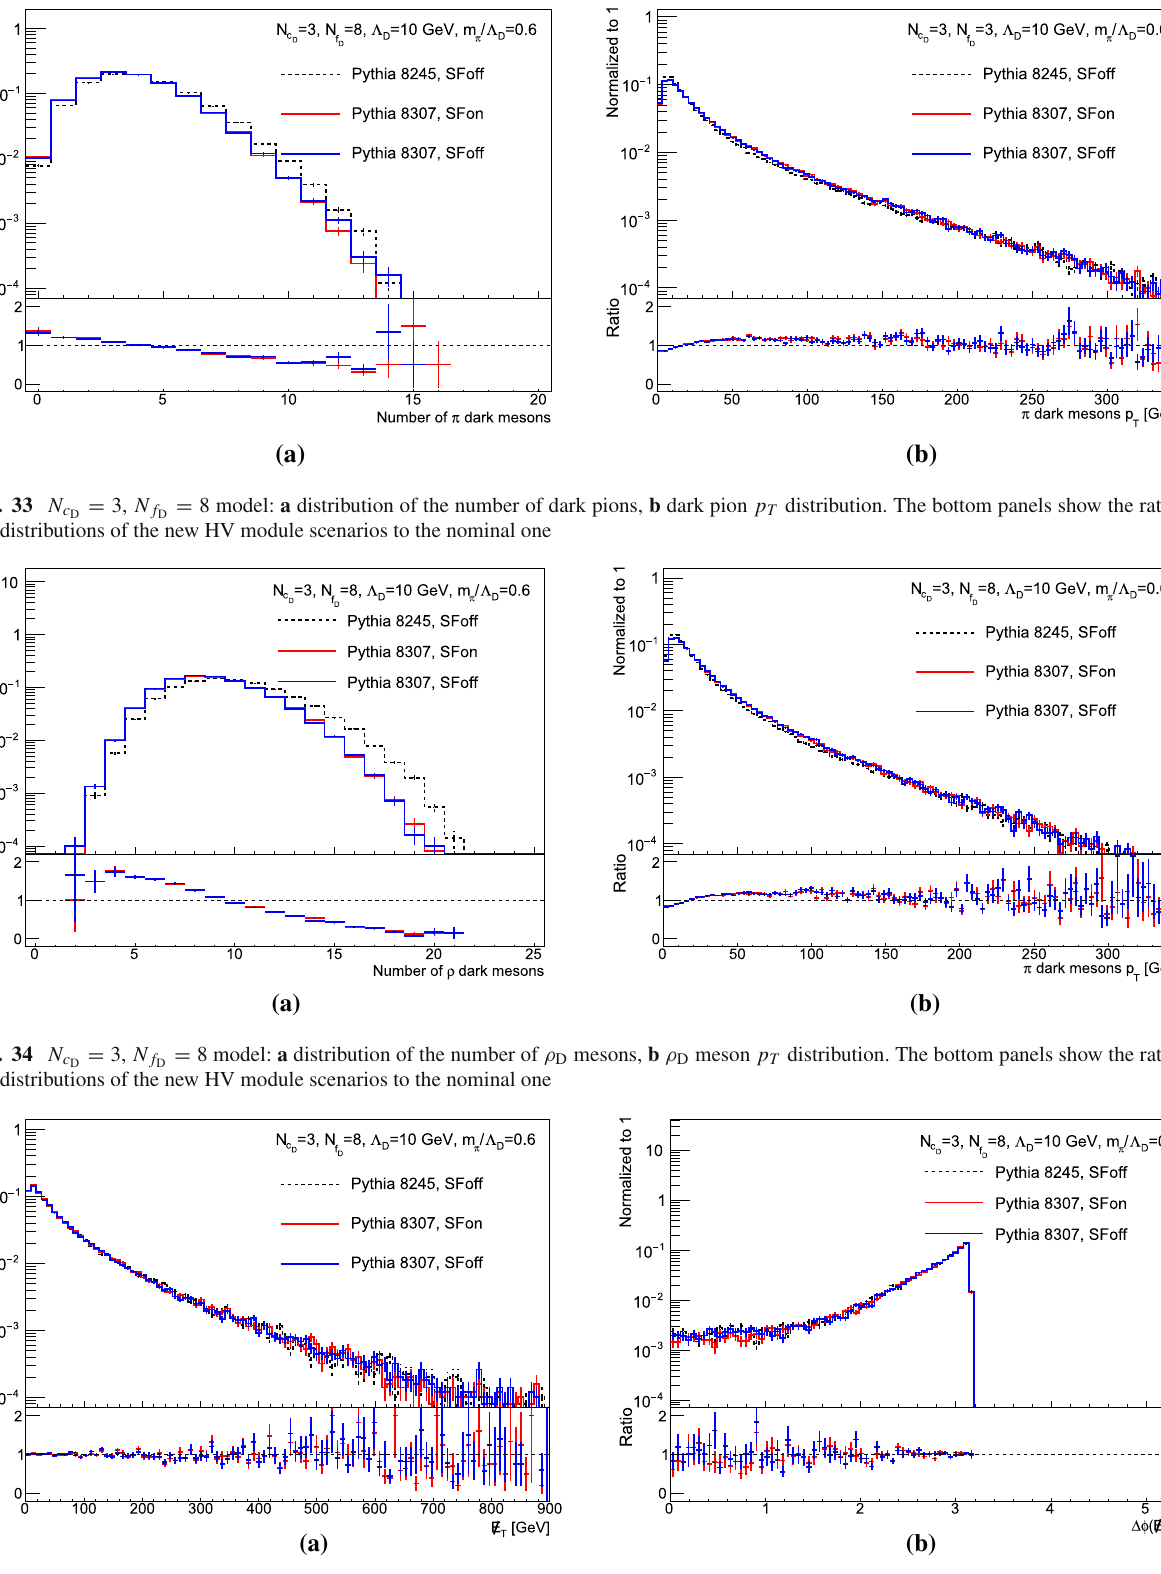
T , b distribution of the minimum azimuthal